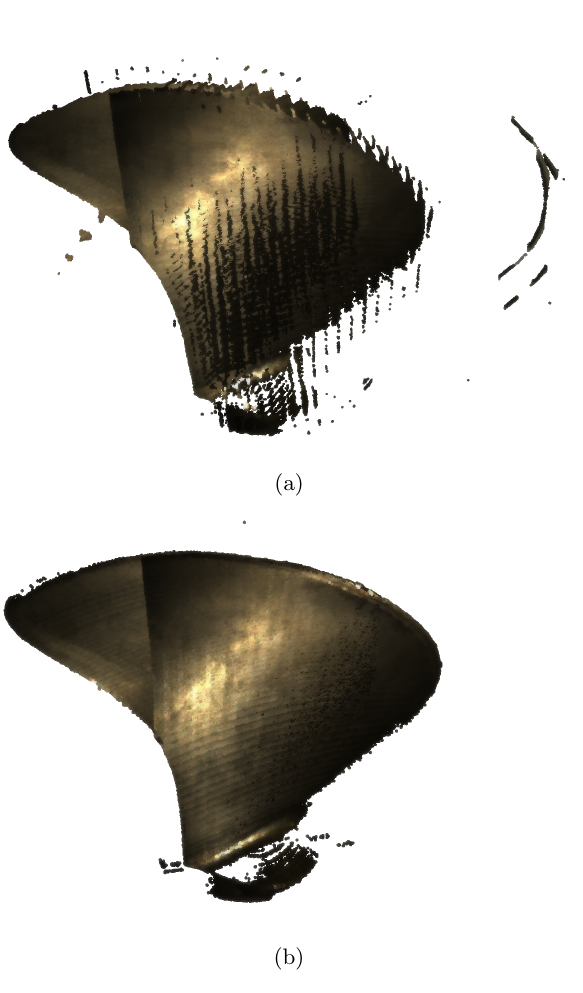
Figure 14: Point clouds of the propeller blade acquired using the unshaped reference trajectory (a) and the ZVD shaped trajectory